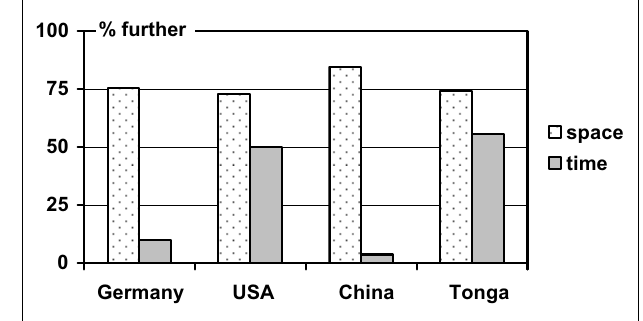
FIGURE 3 | Percentage of individuals assigning FRONT further away from the observer in the static and the dynamic tasks (cf.Table 4).